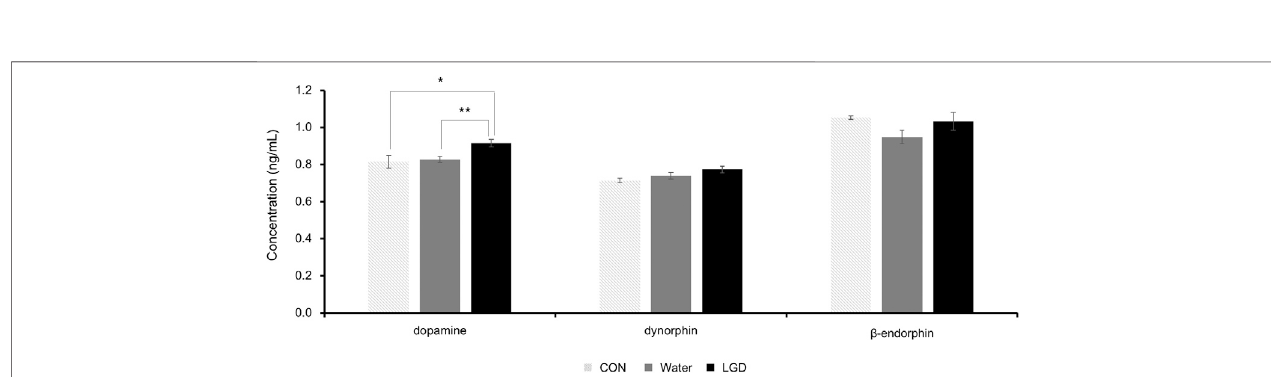
FIGURE6| Changesindopamine,dynorphin,and β -endorphinlevelsinbraintissuesofactivity-basedanorexia(ABA)miceafteradministrationoflicoriceanddried ginger decoction (LGD). Results are expressed as mean ± SEM. Statistical signi fi cance was recorded as * ( p < 0.05) and ** ( p < 0.01).